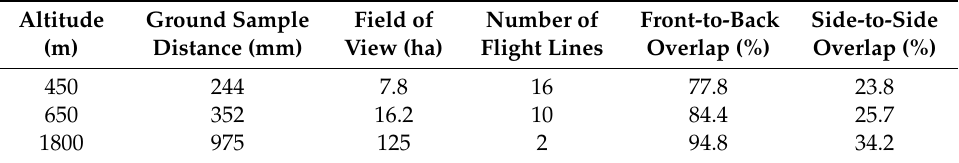
Table 2. Coverage of the Mini-MCA at three altitudes above ground